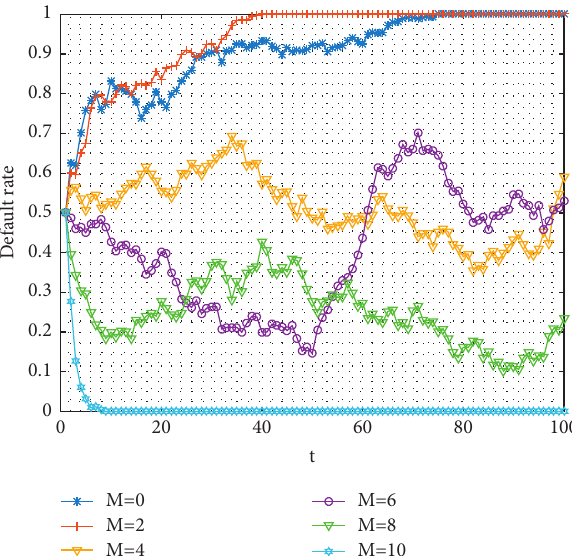
Figure 4: Diffusion of default behavior in a scale-free network , β . when β < β 1 2